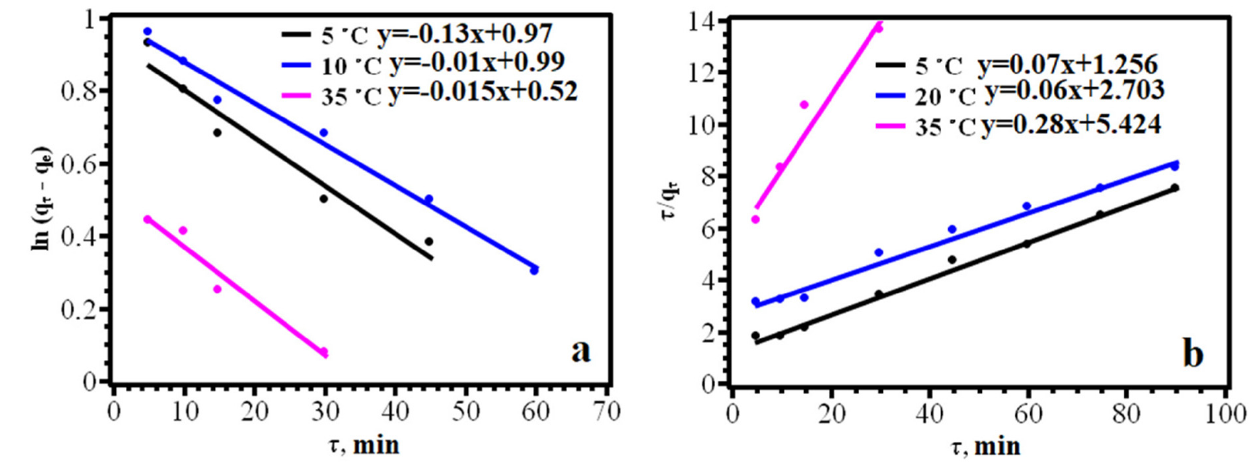
Figure 10. Pseudo-first order ( a ) and pseudo-second order ( b ) models of the solid-phase extraction rate for IC dye. Table 4. Kinetic parameters of the process of adsorption by a nanocomposite.